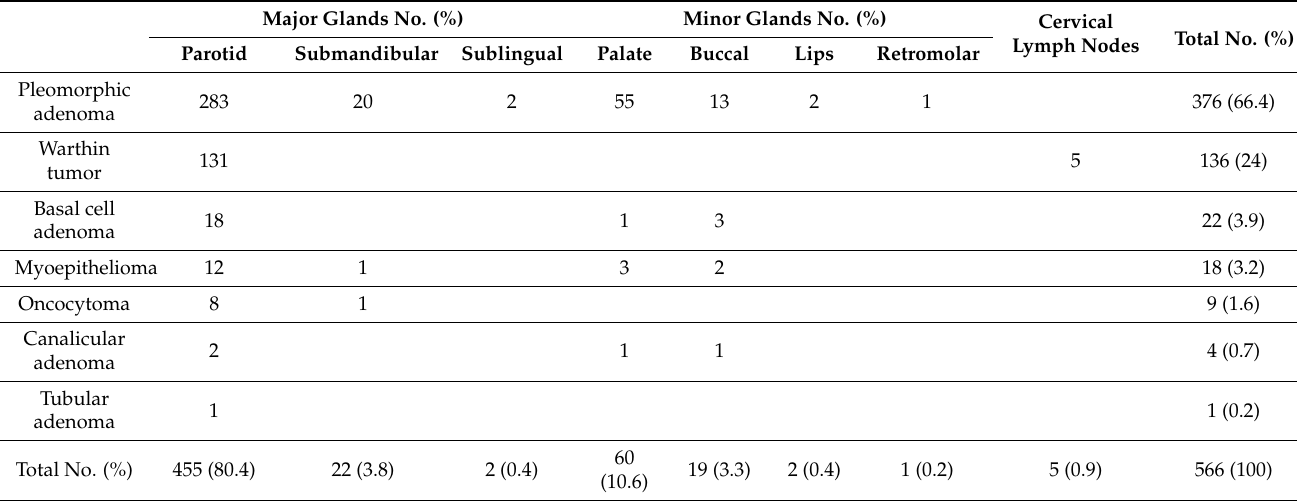
Table 1. Location and histological type of benign salivary gland tumors.